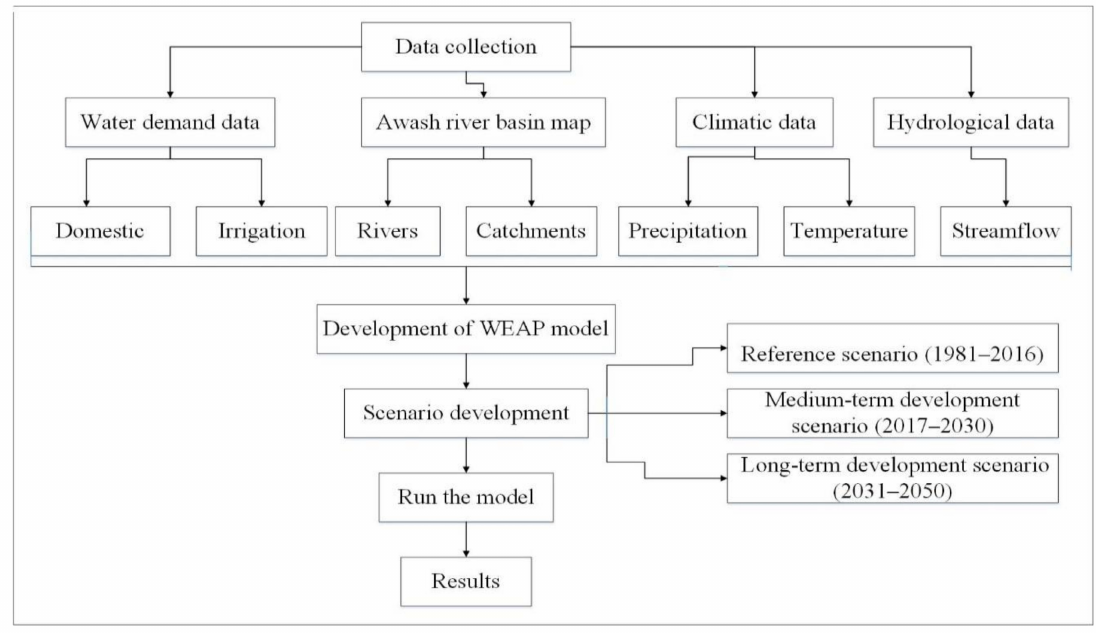
Figure 2. Methods of estimating water demands through the WEAP